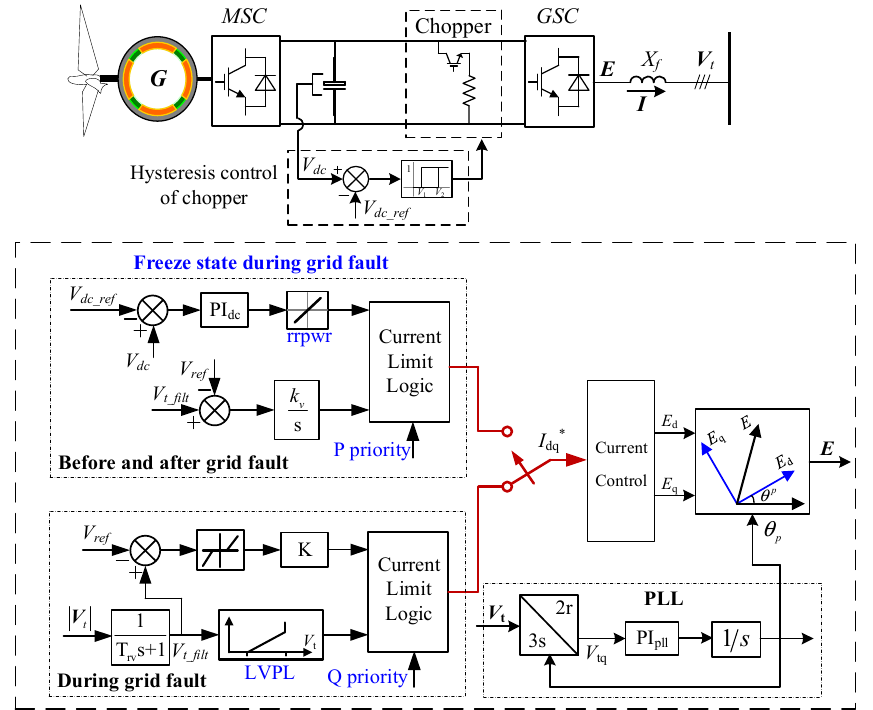
Figure 1. Typical auxiliary control and circuit in response to grid faults.